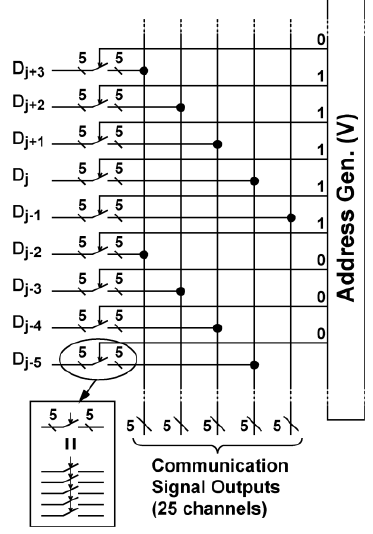
Figure 4. Row selector for Communication Signal Bus.